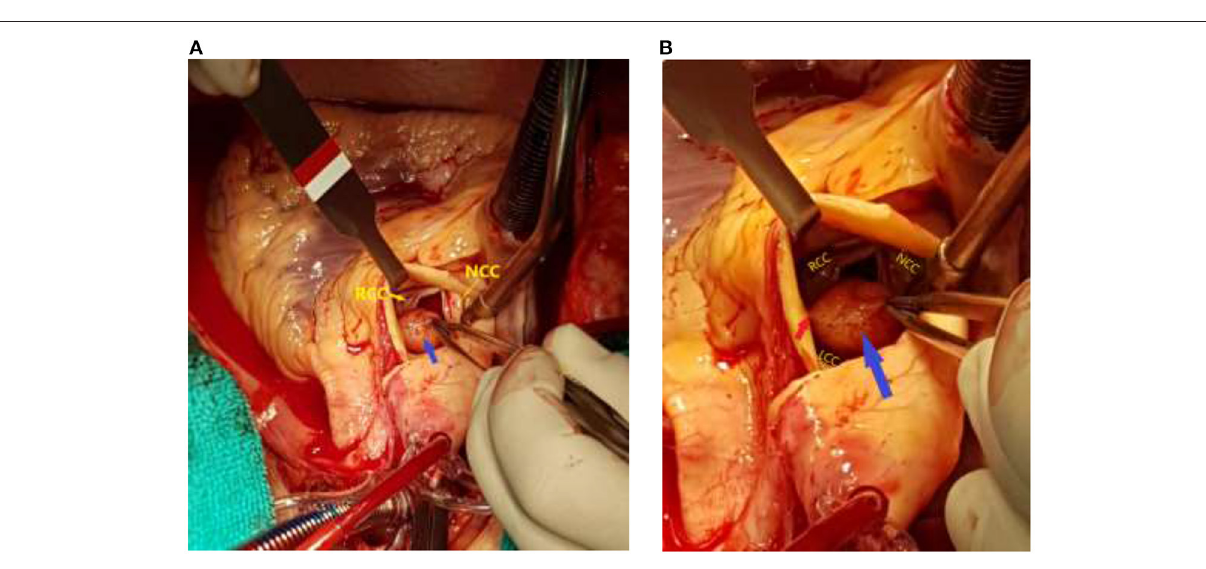
FIGURE 3 | Surgical view after transverse aortotomy: (A) Fibroelastoma (blue arrow) localization in the Valsalva sinus. (B) A tumor (blue arrow) was attached by a thin stalk (red arrow) between the right and left coronary aortic cusps at the aortic side. Notice normal anatomical preservation of the aortic valve leaflets. The left coronary cusp was hidden behind the tumor. (RCC) Right coronary cusp. (NCC) Noncoronary cusp. (LCC) Left coronary